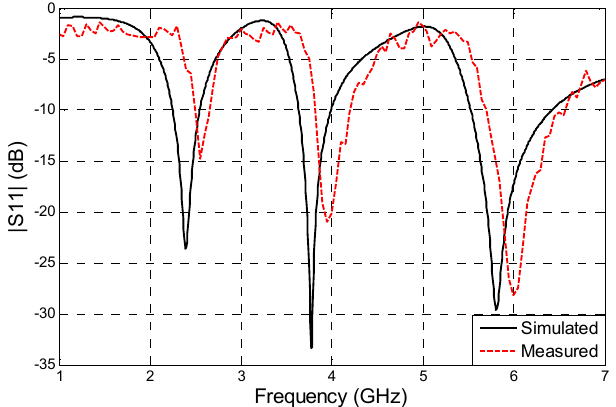
Figure 11. The simulated and measured reflection coefficients of the proposed antenna.